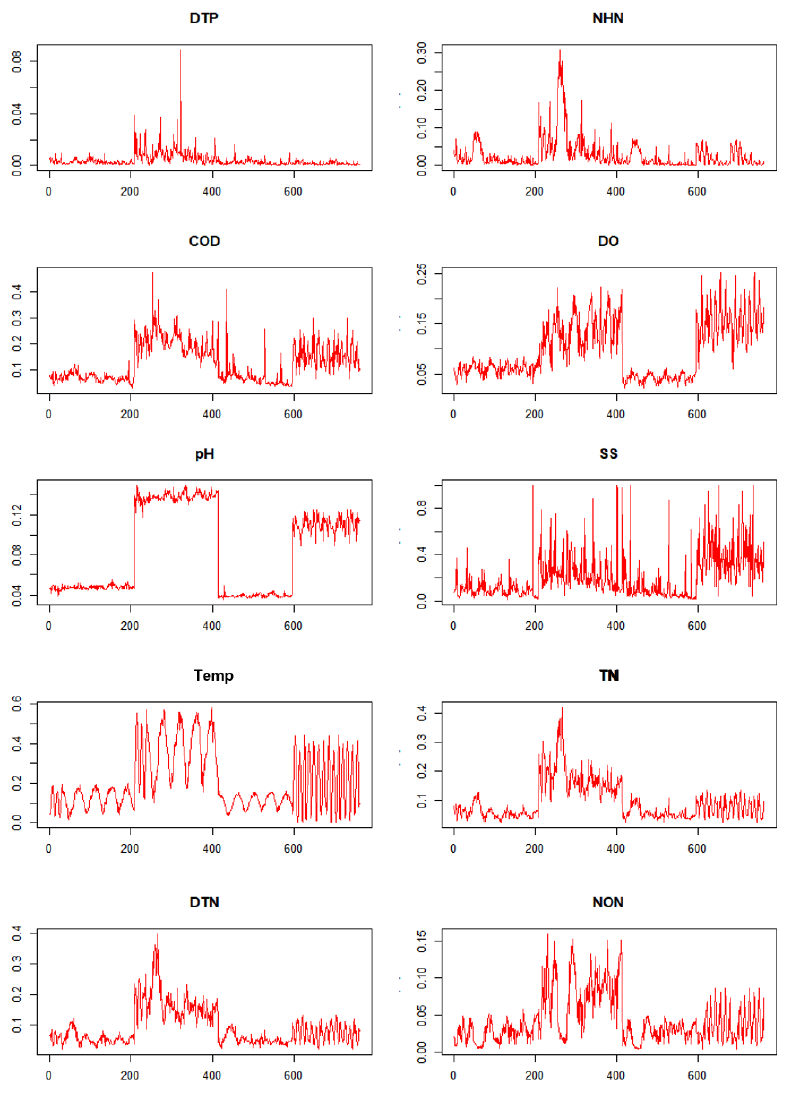
Figure 5. Data visualization.